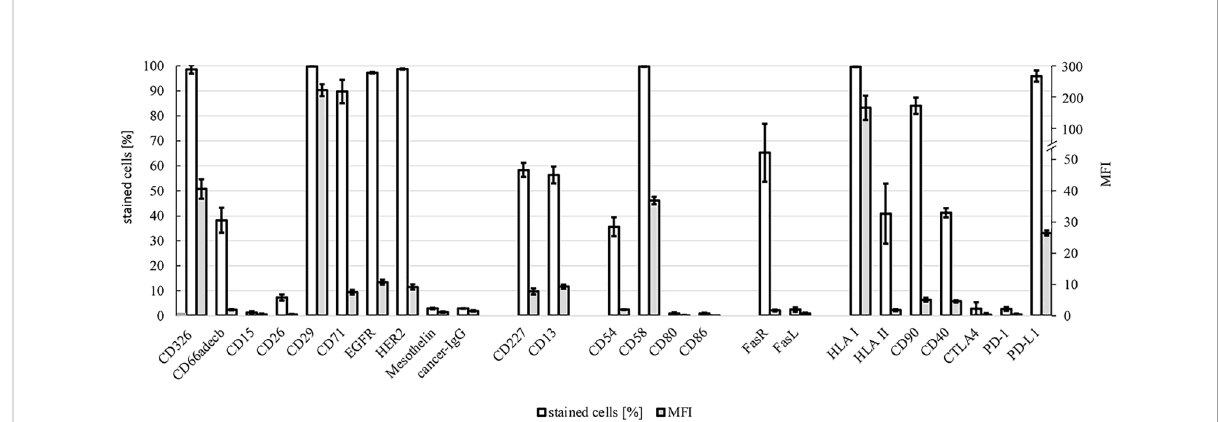
FIGURE 6 Flow cytometry. Expression of surface markers in HROP68Tu2 cells: tumor markers/signaling/proliferation (CD326, CD66adecb, CD15, CD26, CD29, CD71, EGFR, HER2, mesothelin, and cancer IgG), drug resistance (CD227 and CD13), adhesion/cell – cell interaction (CD54, CD58, CD80, and CD86), death ligand and receptor (CD95 and CD178), and immunogenicity/immunosuppression (HLA I, HLA II, CD90, CD40, CTLA4, PD-1, and PD-L1) were assessed by fl ow cytometry using FACS Calibur. Positively stained cells are given in % ± SEM and MFI (mean fl uorescence intensity) ± SEM.